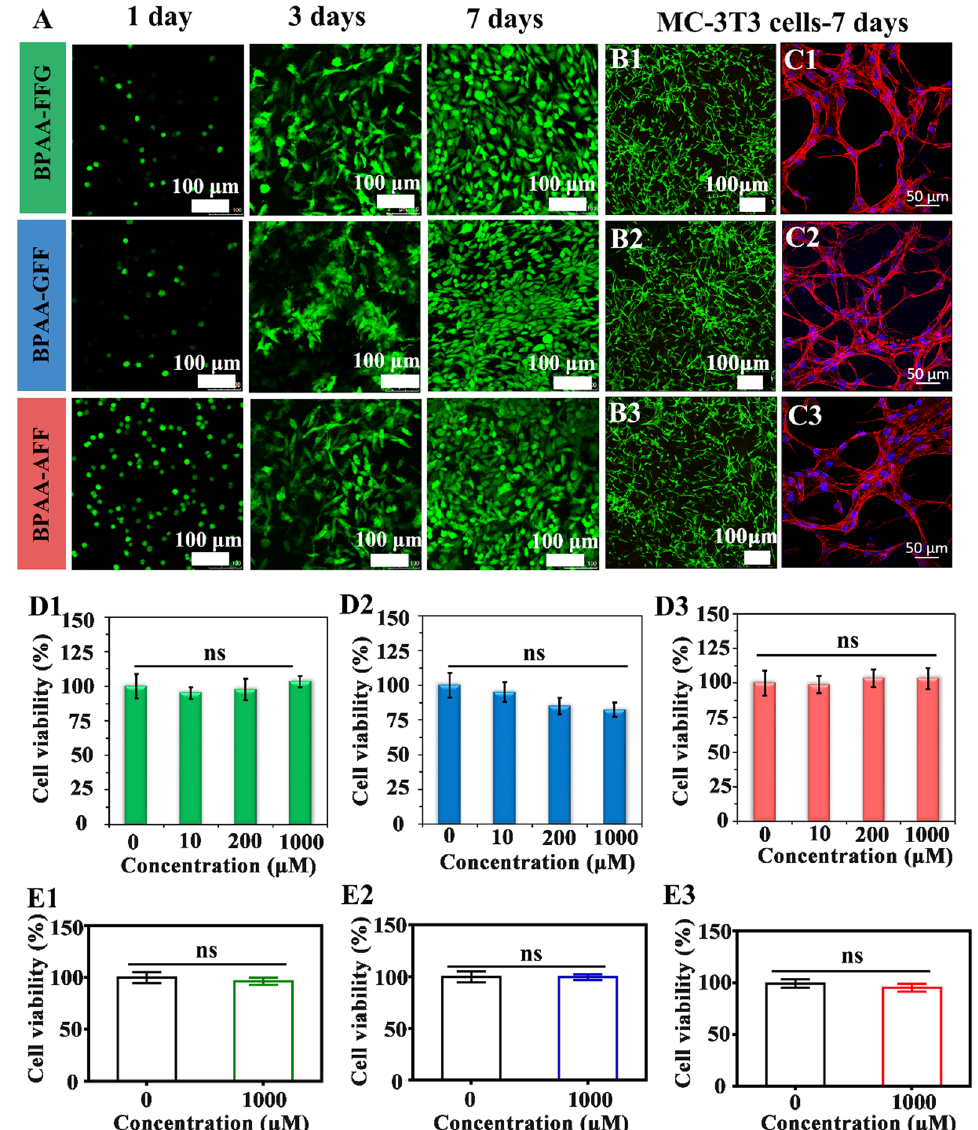
Fig. 5 A CLSM images (FDA/PI staining) of L929 cells encapsulated into Gel-FFG, Gel-GFF and Gel-AFF. B1 – B3 CLSM images (FDA/PI staining) of MC-3T3 cells encapsulated into Gel-FFG, Gel-GFF and Gel-AFF. C1 – C3 CLSM images (Rhodamine-phalloidin/DAPI staining) of MC-3T3 cells encapsulated into Gel-FFG, Gel-GFF and Gel-AFF. D1 – D3 The viability of L929 cells encapsulated into the hydrogels with different concentration of BPAA-FFG, BPAA-GFF and BPAA-AFF. E1 – E3 The viability of MC-3T3 cells encapsulated into the hydrogels with different concentration of BPAA-FFG, BPAA-GFF and